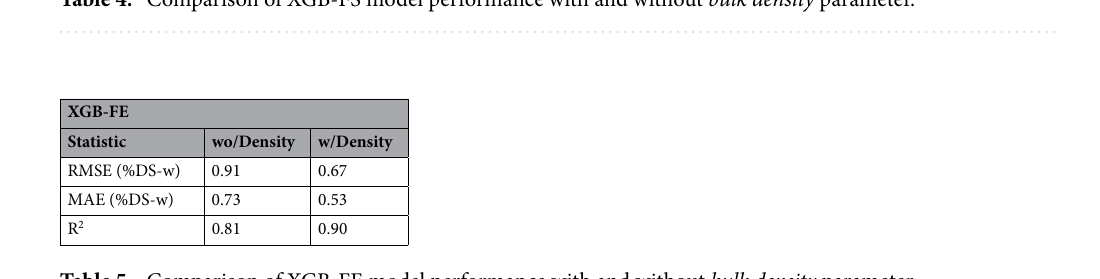
Table 5. Comparison of XGB-FE model performance with and without bulk density